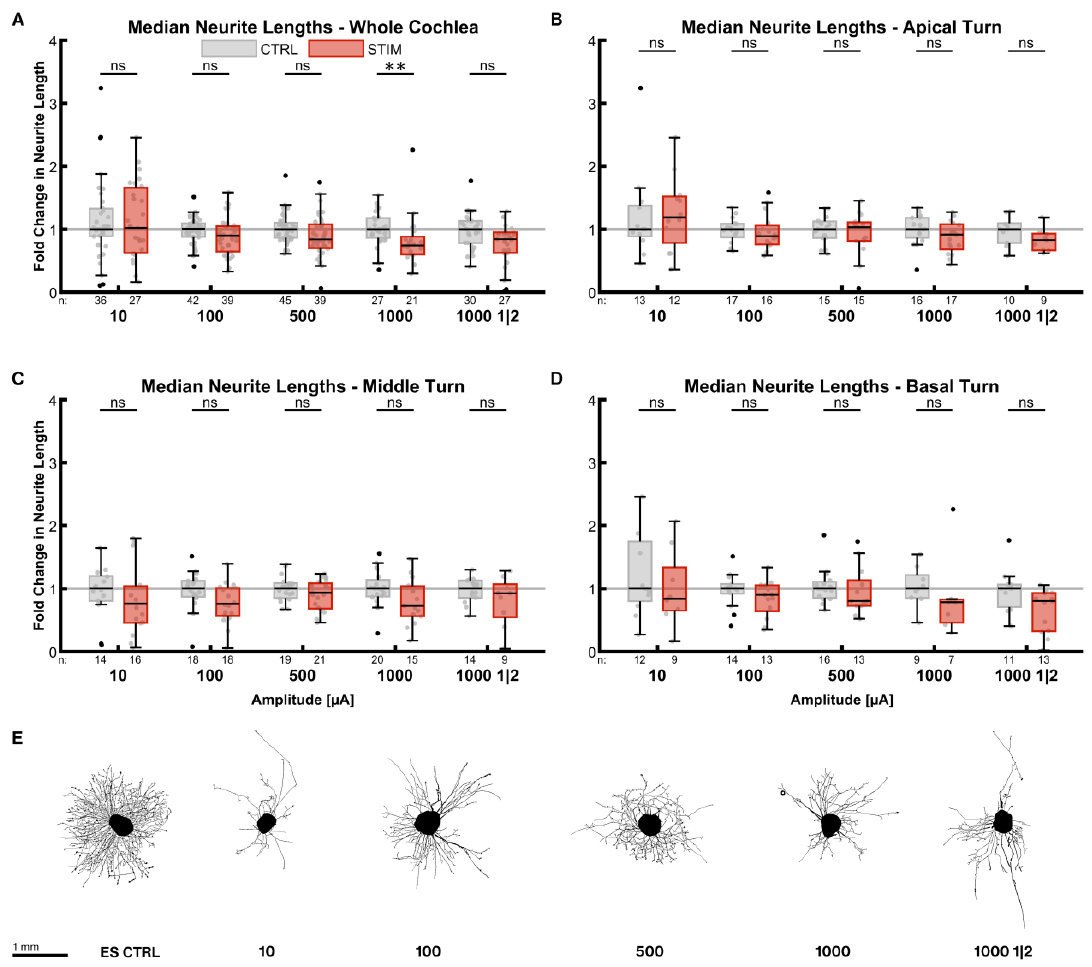
Figure 4. Median neurite lengths after electrical stimulation. The diagrams ( A – D ) show the fold change of the median neurite length regarding the median of the control group after ES with different amplitudes. All groups were supplemented with 25 ng/mL BDNF. The fold change was normalized to the electrically unstimulated controls on the same plate. Therefore, every electrically stimulated group has its own unstimulated control group. 1000 1|2 designates the 1 min on, 2 min off stimulation pattern with 1000 µ A amplitude. The groups in the first graph ( A ) contain an equal number of samples from three turns, hence representing the whole cochlea. Diagrams ( B – D ) depict the individual turns. ( A – D ) The boxes extend from the 25% to the 75% percentile. The black bar denotes the median. The whiskers delimit the 1.5-fold interquartile range. Samples within this range are marked as grey dots, and samples beyond this range are black. A grey line marks the median of the control group. The number of samples in each group is written right below the X-axis. The asterisks or ns (not significant) above the groups indicate the significance level of a groupwise Mann–Whitney test, followed by a Holm–Š í d á k correction against the corresponding control group. ( E ) Representative explants at the median of the best-performing groups in ( A